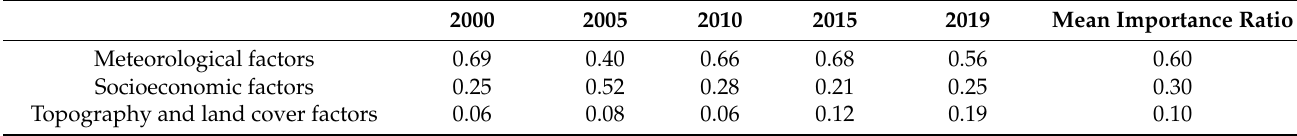
Figure 5. Changes in SHAP values of influencing factors for the five selected years. Table 3. Importance ratio of influencing factors.